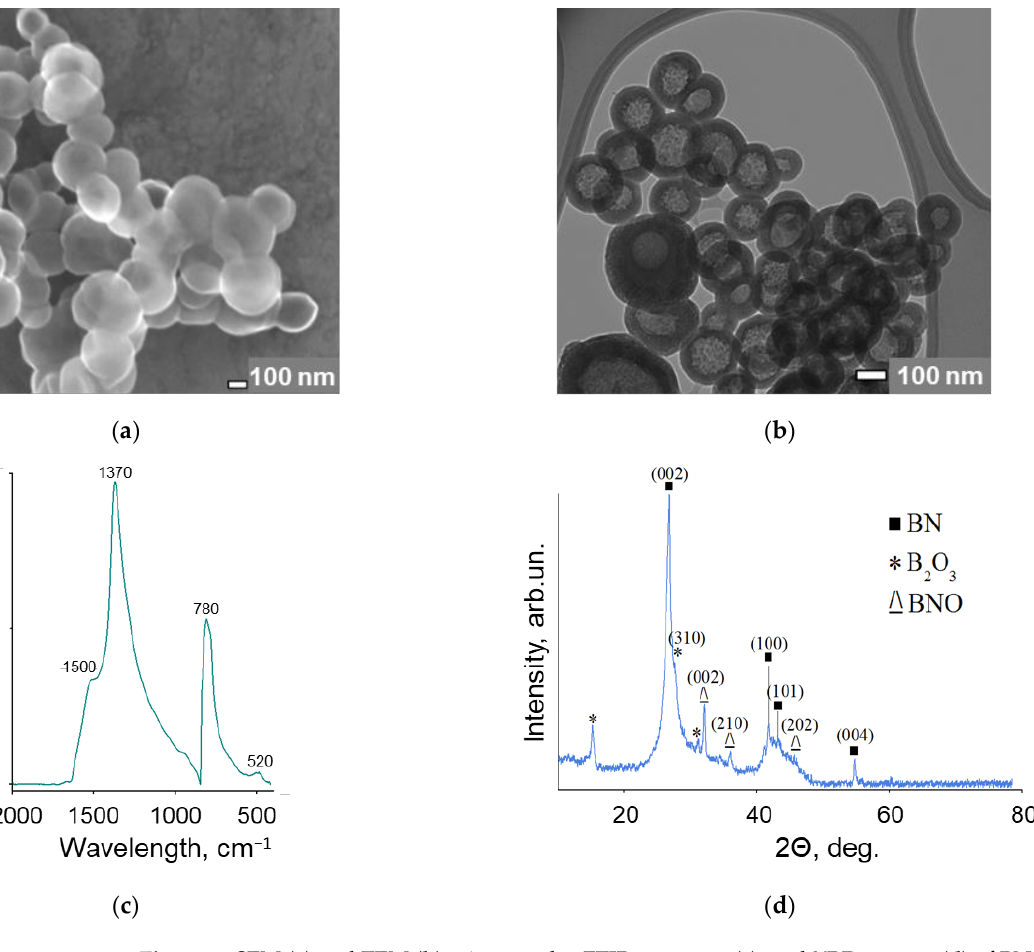
Figure 1. SEM ( a ) and TEM ( b ) micrographs, FTIR spectrum ( c ), and XRD pattern ( d ) of BN nanoparticles.